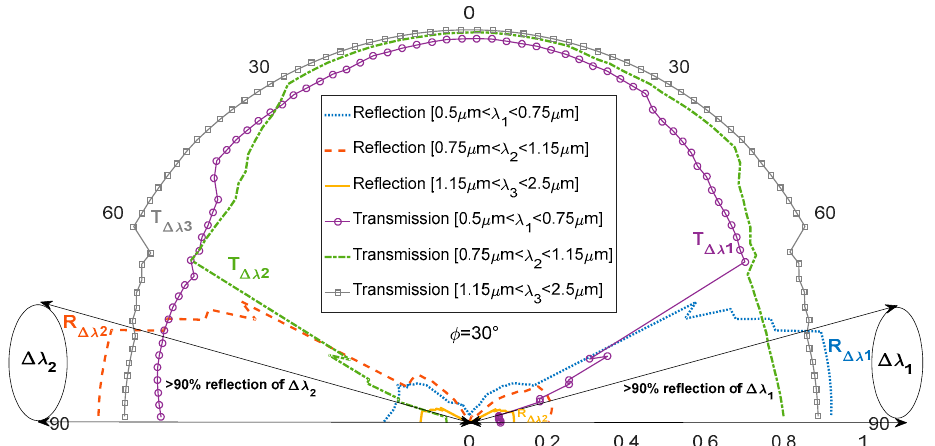
Figure 18. Directional reflection and transmission for three different spectral regions for five double multilayers (10 Layers). 𝜙 = 30° .